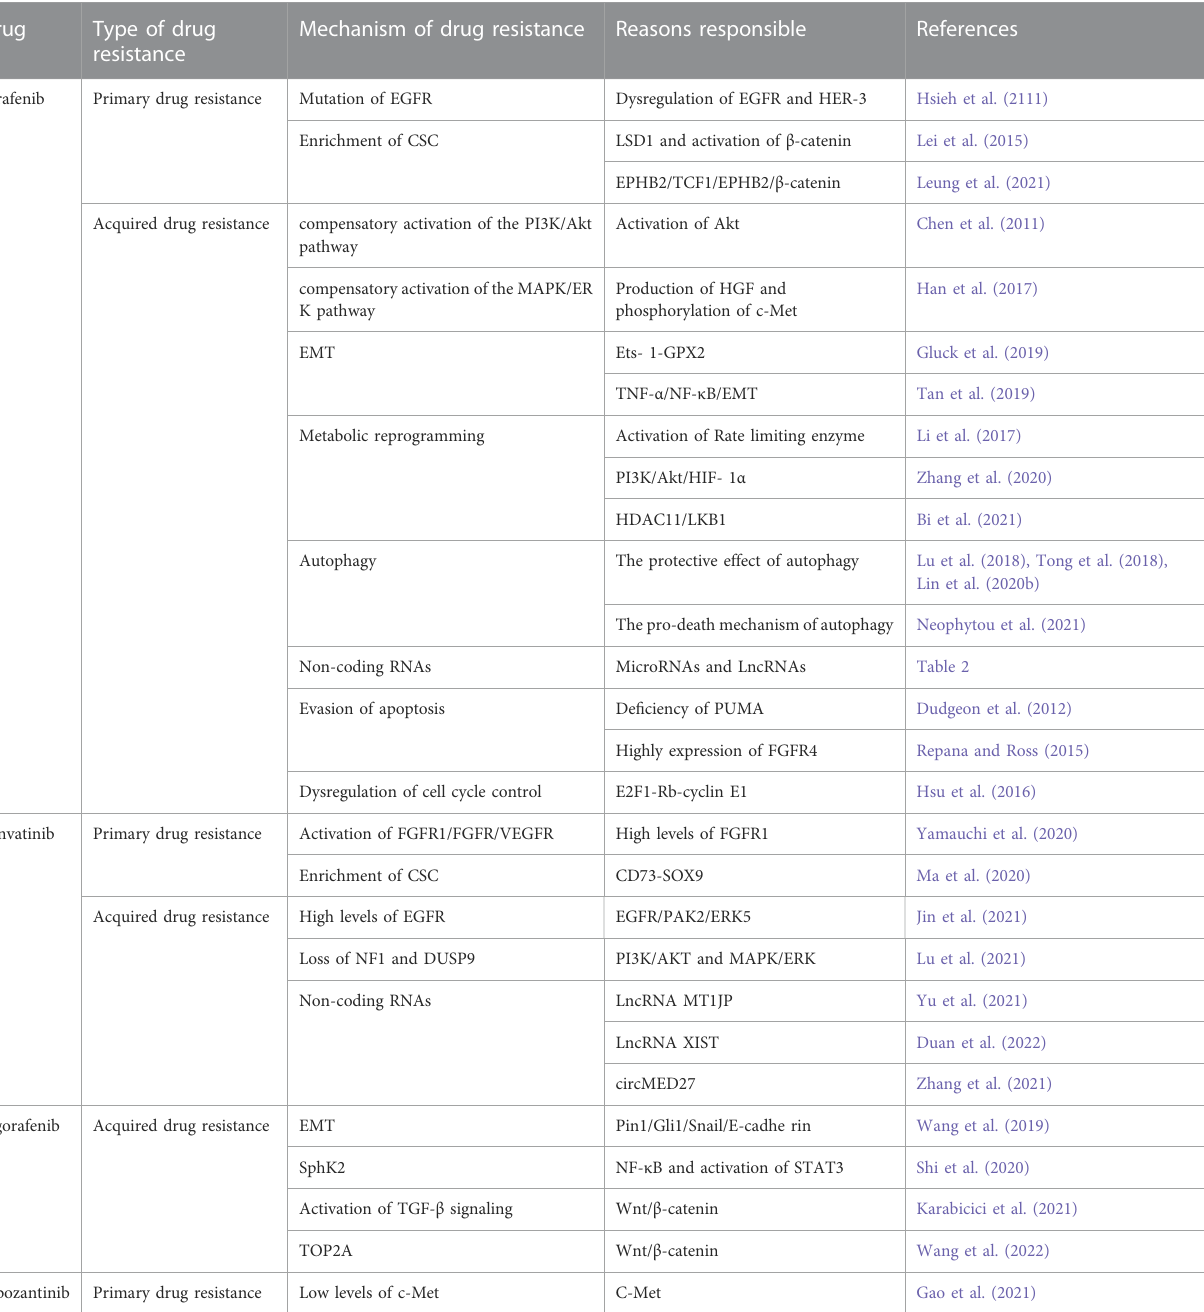
TABLE 1 Summary of previous studies with the mechanisms of receptor tyrosine kinase drug resistance in